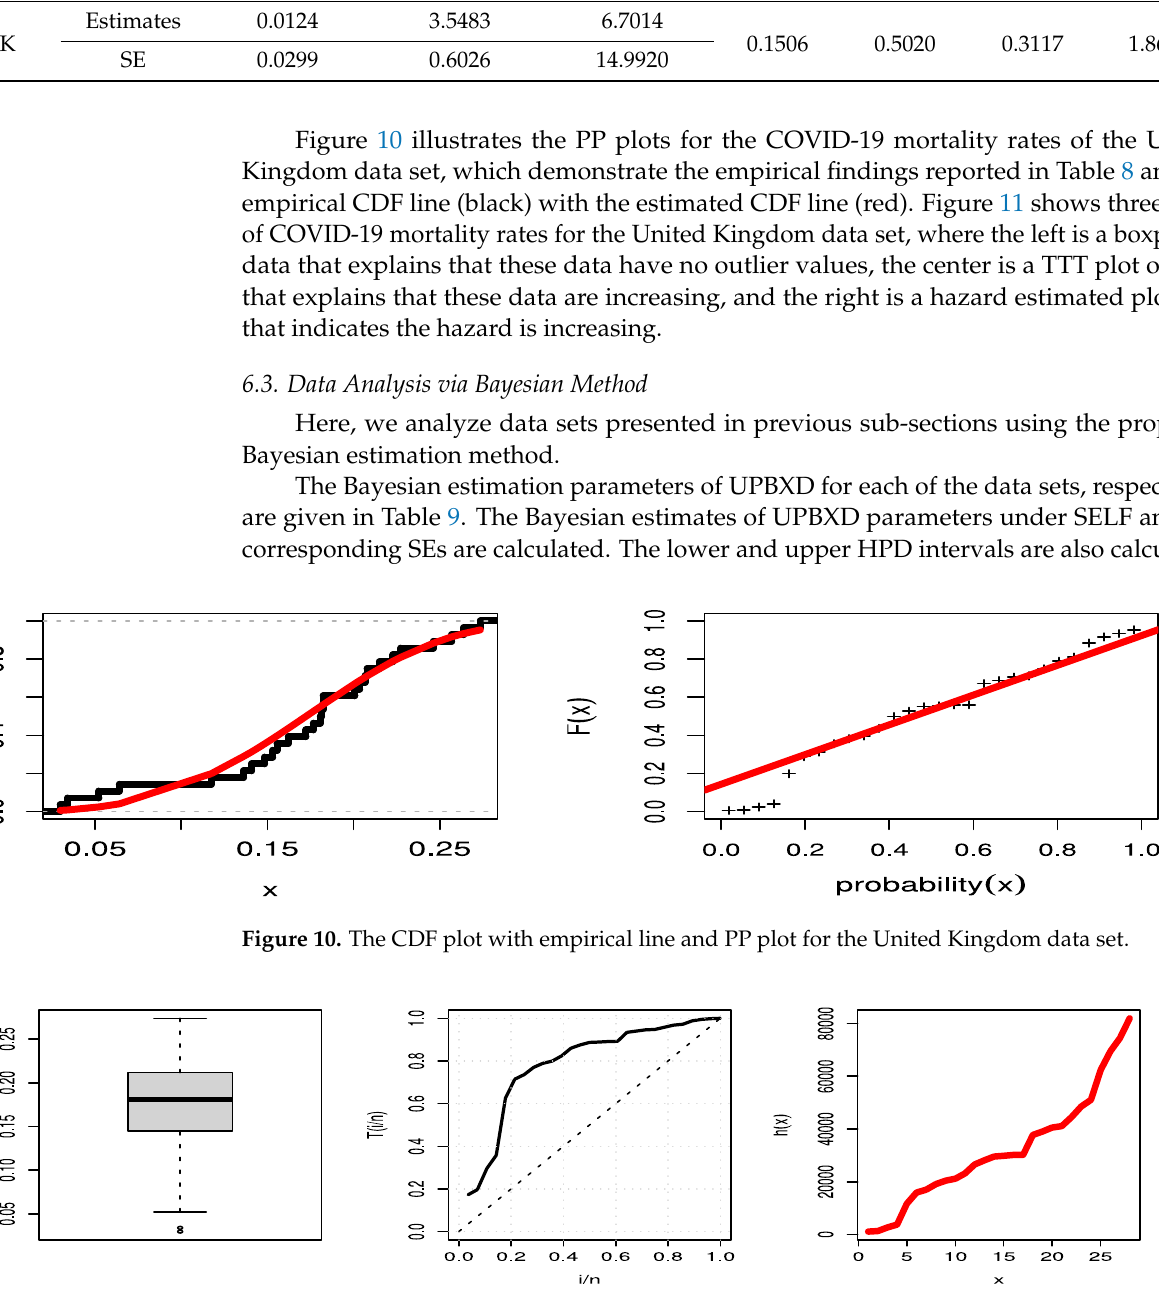
Figure 11. Boxplot, TTT plots and hazard line of UPBXD plot for the United Kingdom data set.